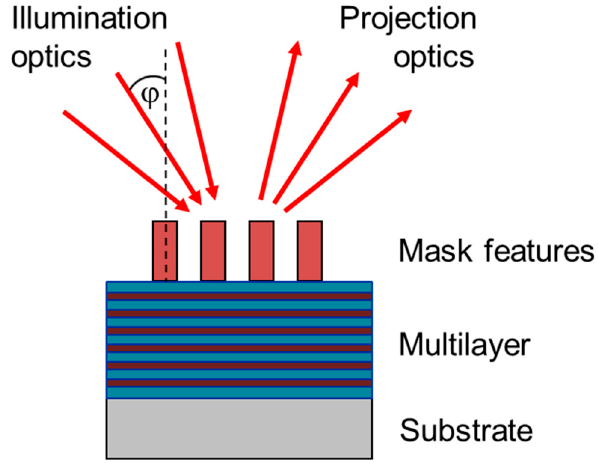
Figure 8. Principle of illumination of an EUV mirror and mask. ϕ denotes the chief ray angle.